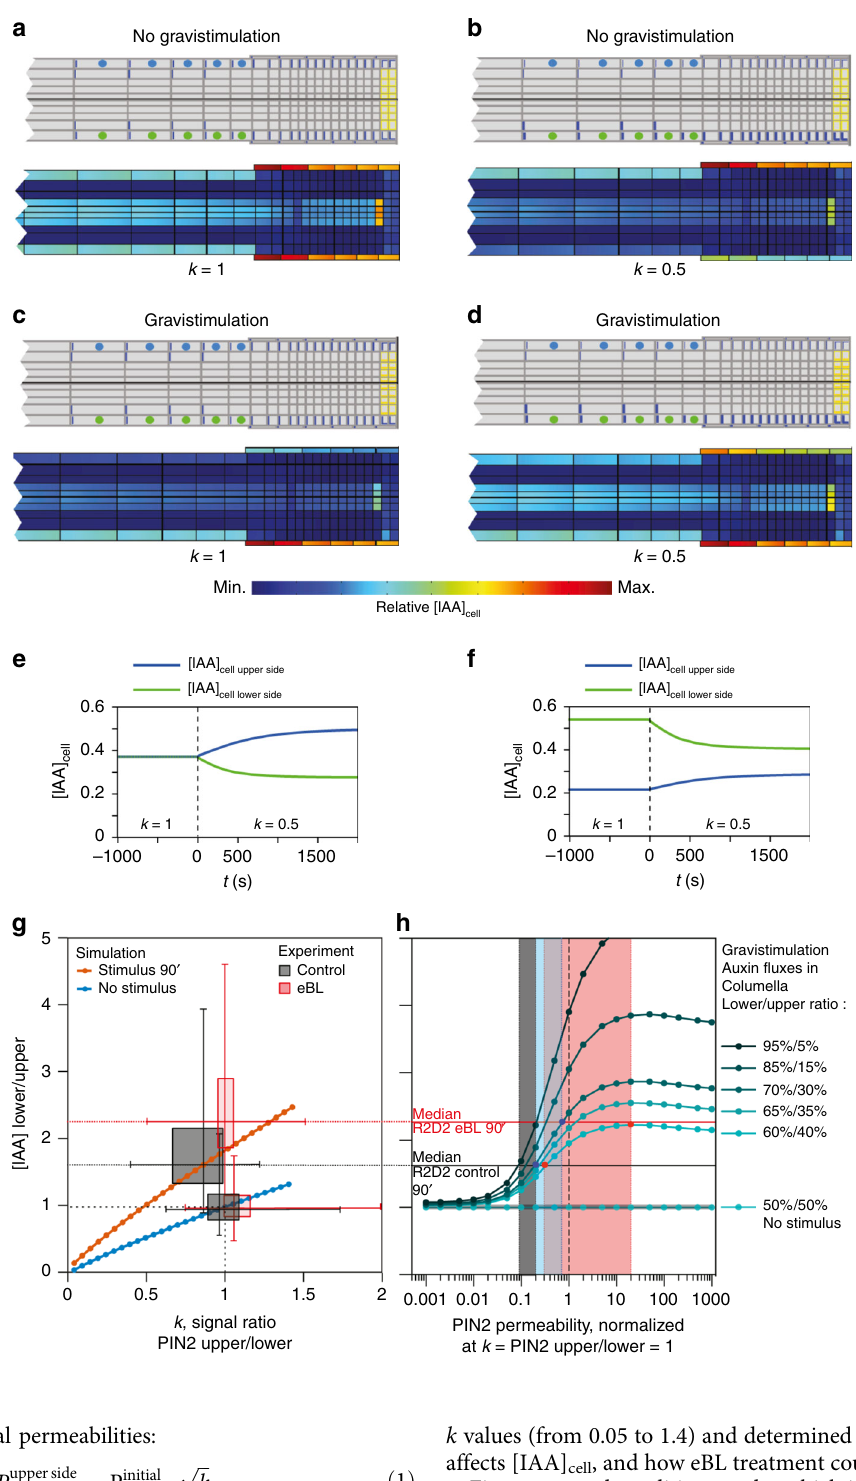
(Fig. 8b, e): with an asymmetry coef fi cient k = 0.81, we obtained ffi 0 : 8 (calculated for epidermal cells of the elongation IAA lowerside IAA upperside zone; Fig. 8b, g; blue curve). A linear relationship between P